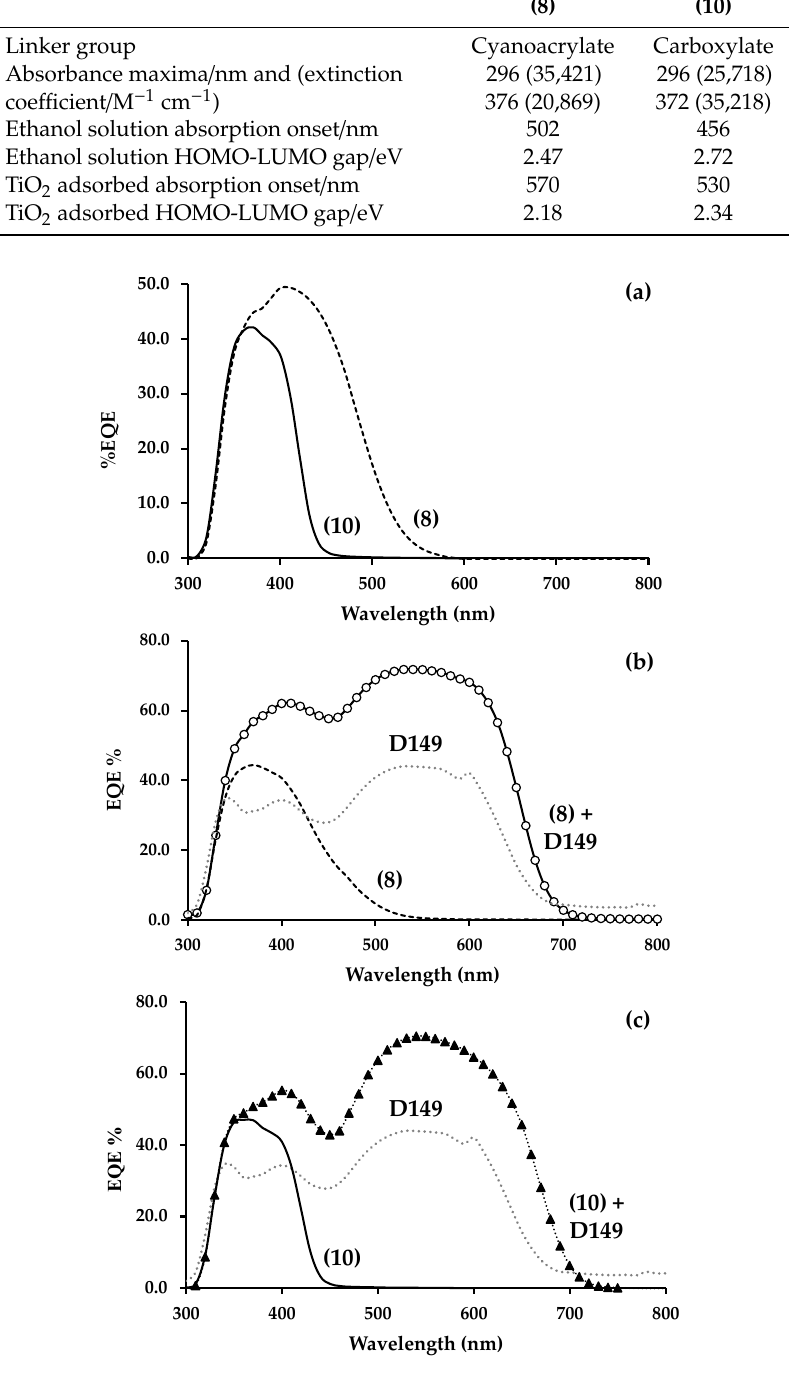
Figure 2. External quantum efficiency (EQE) versus wavelength for ( a ) singly dyed dye-sensitized solar cells (DSC) devices of ( 8 ) and ( 10 ), ( b ) singly dyed DSC devices of ( 8 ), D149 and co-sensitized ( 8 ) + D149 and ( c ) singly dyed DSC devices of ( 10 ), D149 and co-sensitized ( 10 ) + D149. Table 1. Spectral data for solution and TiO 2 adsorbed dyes.